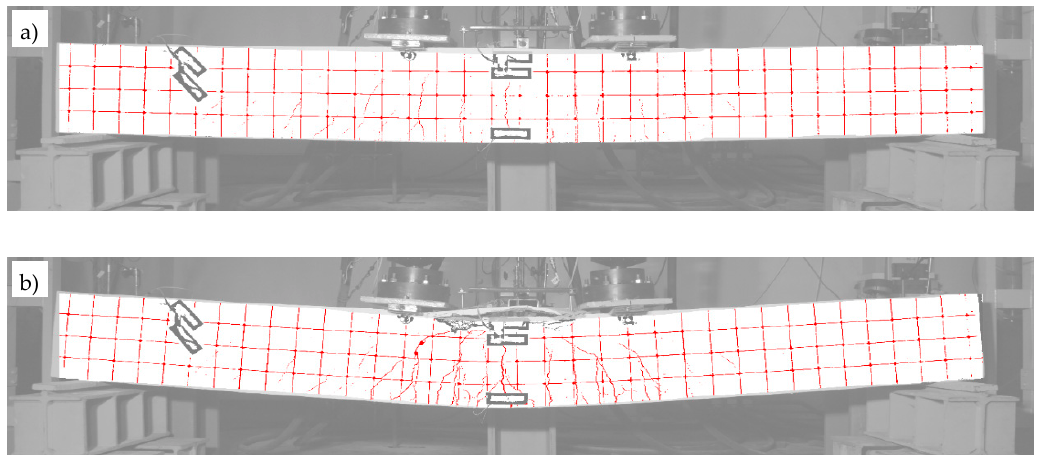
Figure 36. Views of the cracking of beam #3: ( a ) at the same deflection as for beam #2 in Figure 35a; ( b ) at the moment of the beam’s destruction. In order to increase the clarity of the figure, the instrumentation, the places where the strain gauges were glued, and the top concrete cover’s delimitation are painted in grey, and the positioning grid (10 cm mesh) and cracks are marked in red.